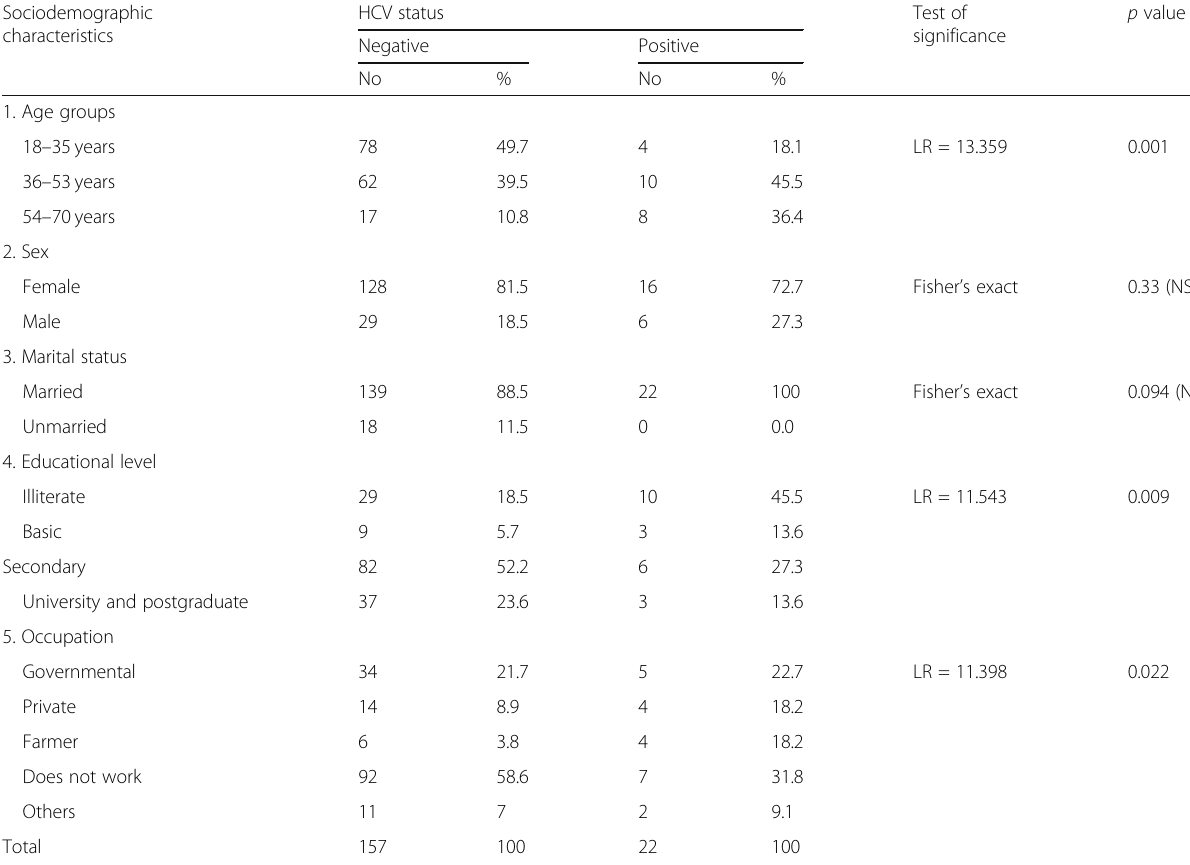
Table 5 The relation of study participants HCV status and their sociodemographic characteristics pre-intervention Sociodemographic